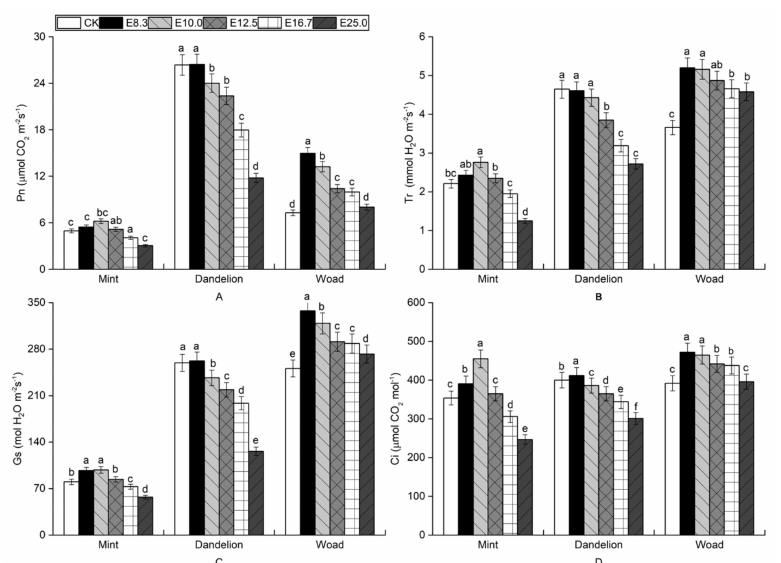
Figure 3. Effect of leaf aqueous extract of fig tree on ( A ) Pn, ( B ) Tr, ( C ) Gs and ( D ) Ci of three medicinal plants. Values are reported as mean ± SD, n = 3. CK, 0.0 g/L; E8.3, 8.3 g/L; E10.0, 10.0 g/L; E12.5, 12.5 g/L; E16.7, 16.7 g/L; E25.0, 25.0 g/L. Lowercase letters represent significant differences in each treatment group ( p < 0.05).